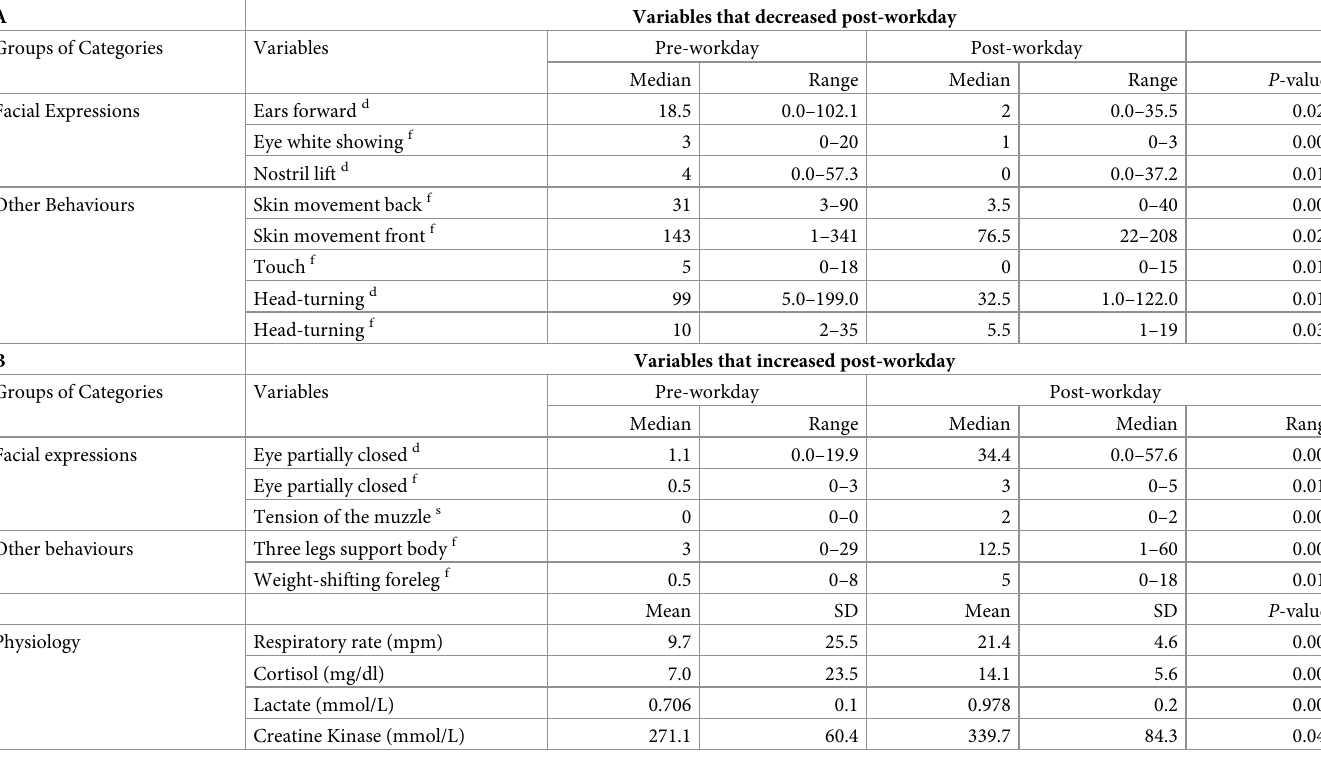
Table 4. Overview of the facial expressions, other behaviours, and physiological variables that decreased (A) or increased (B) when comparing the pre- and immedi- ately post-workday assessments in 14 ranch horses. Physiological parameters are presented using the 30 min and 12 h post-workday assessments for lactate and creatine kinase, respectively. Medians and ranges (maximum-minimum) or means and standard deviations (mean ± SD) are